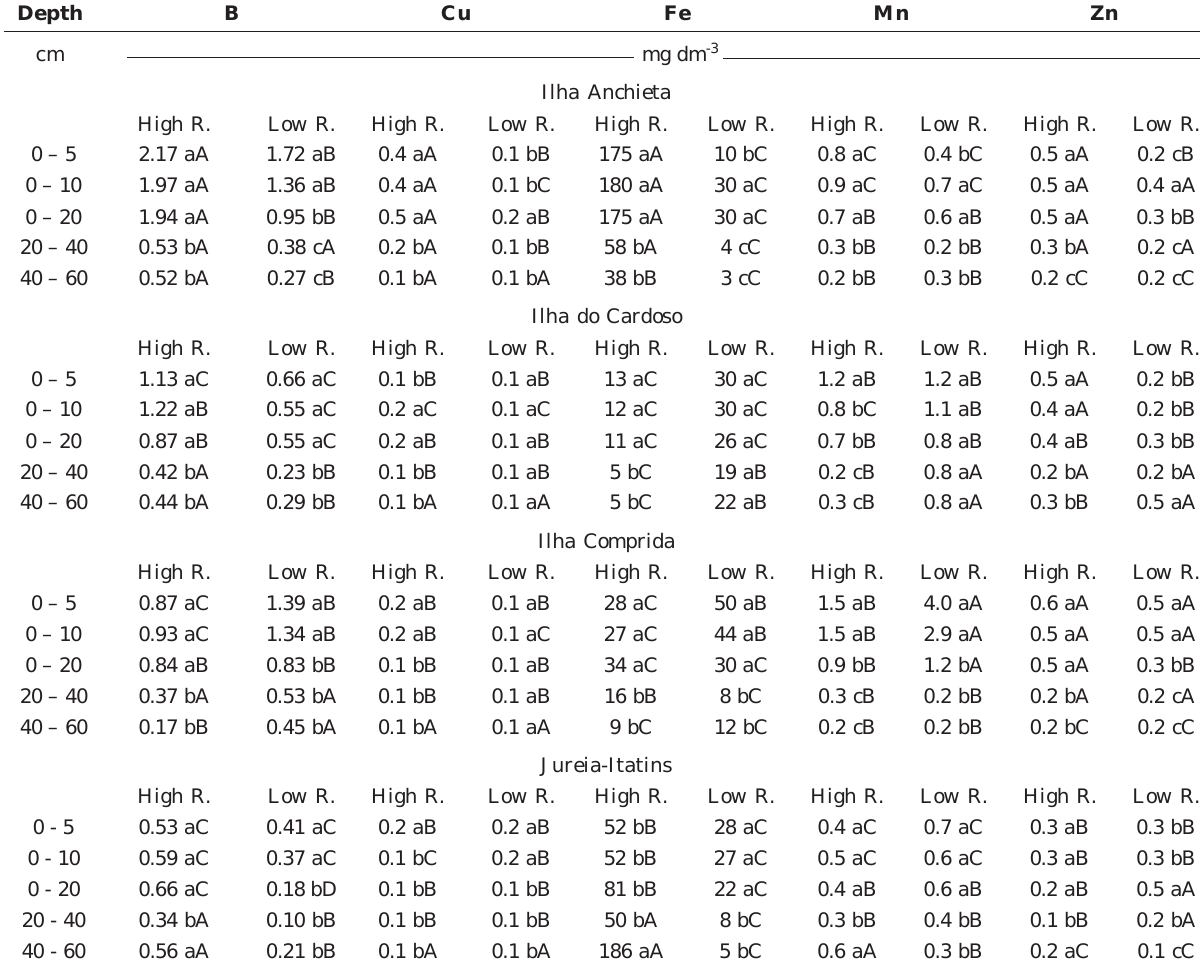
Table 2. Micronutrient contents in the different layers of soils under restinga forests in advanced (high) and intermediate (low) stages of regeneration, at four